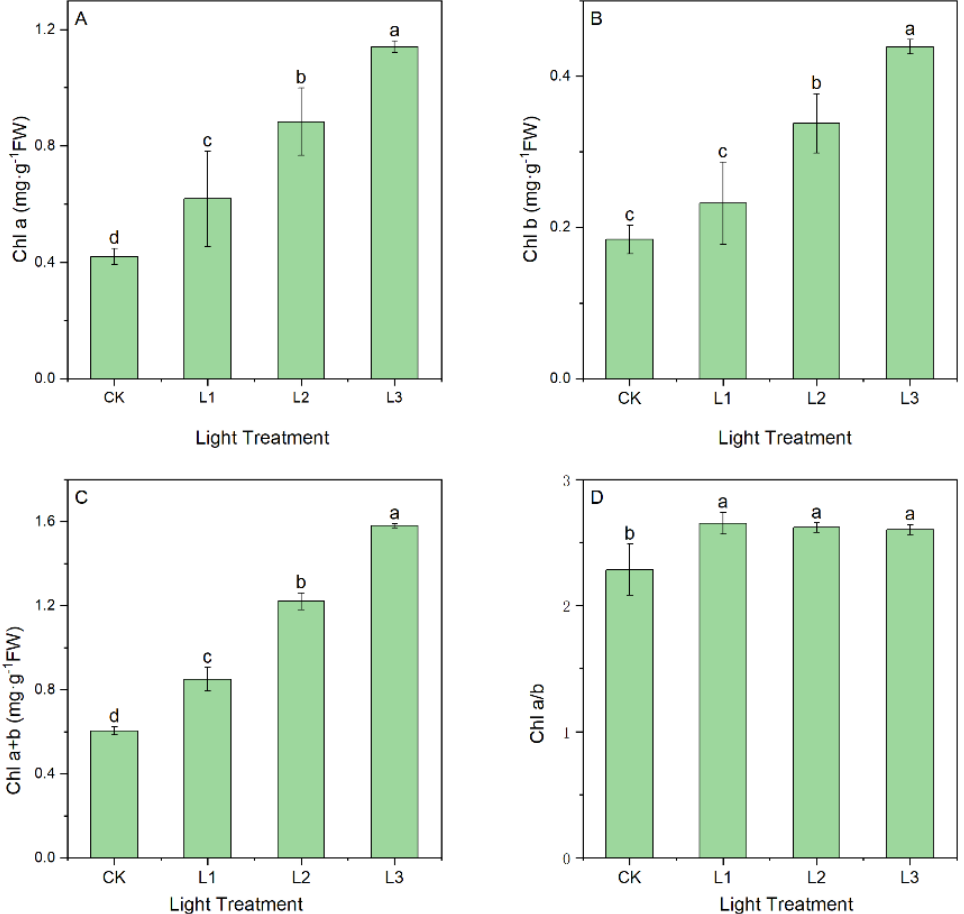
Figure 1. Chl a content ( A ), Chl b content ( B ), Chl a + b content ( C ), and Chl a/b ratio ( D ) in leaves grown under different light intensities. Lowercase letters indicate significant differences under different light intensities ( p <